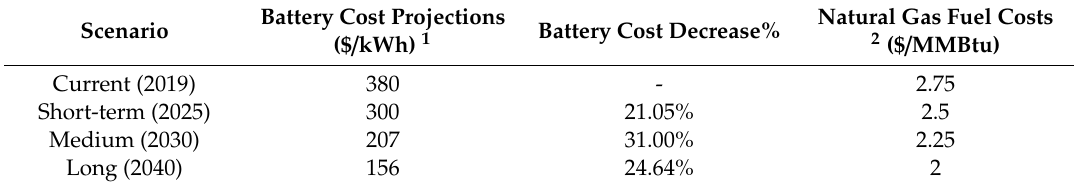
Table 7. Scenarios based on future BESS capital costs and natural gas cost projections.